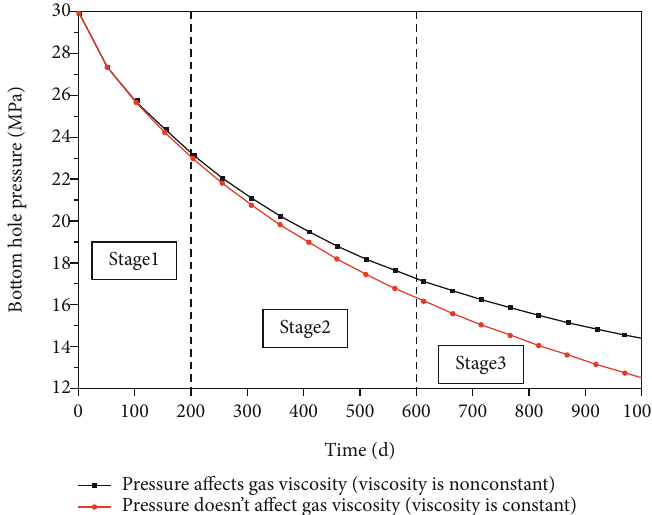
Figure 6: Bottom hole fl owing pressure changes with time under di ff erent gas viscosities. Stage 1: early stage; Stage 2: middle stage; Stage 3: late